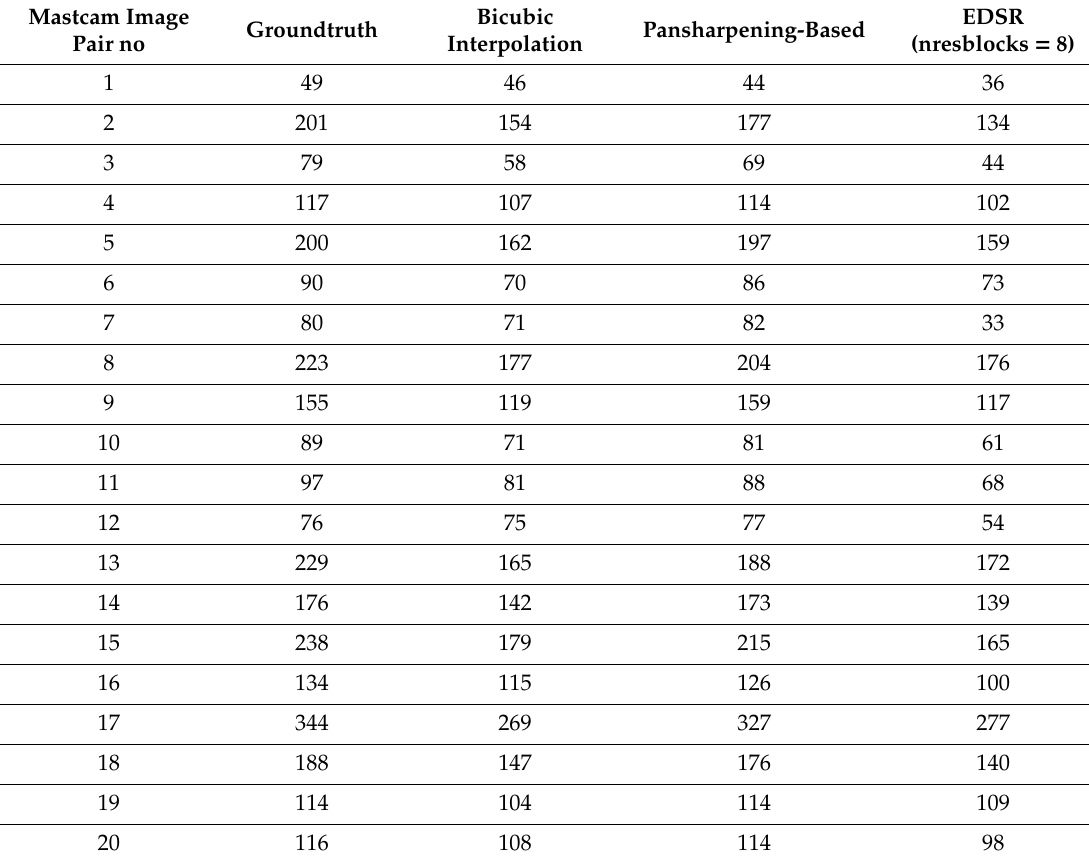
Figure 19. Disparity map estimations with the three methods and the mask for computing average absolute error. Table 8. Number of matching SURF features used in the disparity map